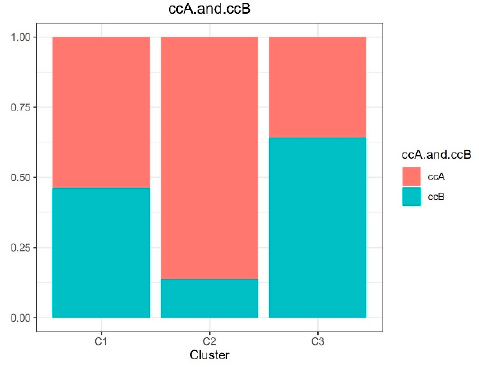
Figure 5. Comparison with previous classification.